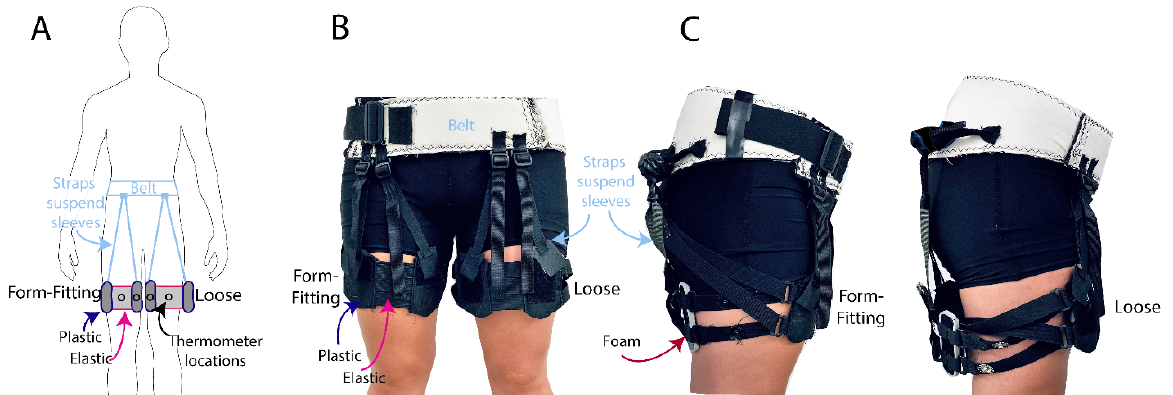
Figure 1. Leg sleeve interfaces in Loose and Form-Fitting modes. ( A ) Schematic of the mode-switching interface design. The symbol ᴼ represents the location of the four thermometers, placed underneath the plastic and elastic components of each leg sleeve during experimental testing. Photographs showing a ( B ) frontal view and ( C ) side view of the Loose and Form-Fitting sleeves.